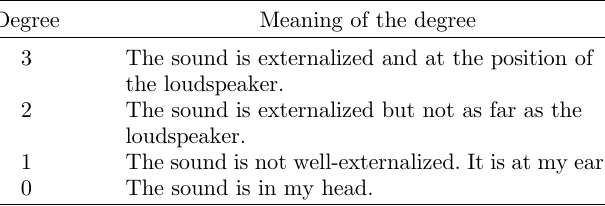
Table 1. Subjective rating scale for perceived externalization.